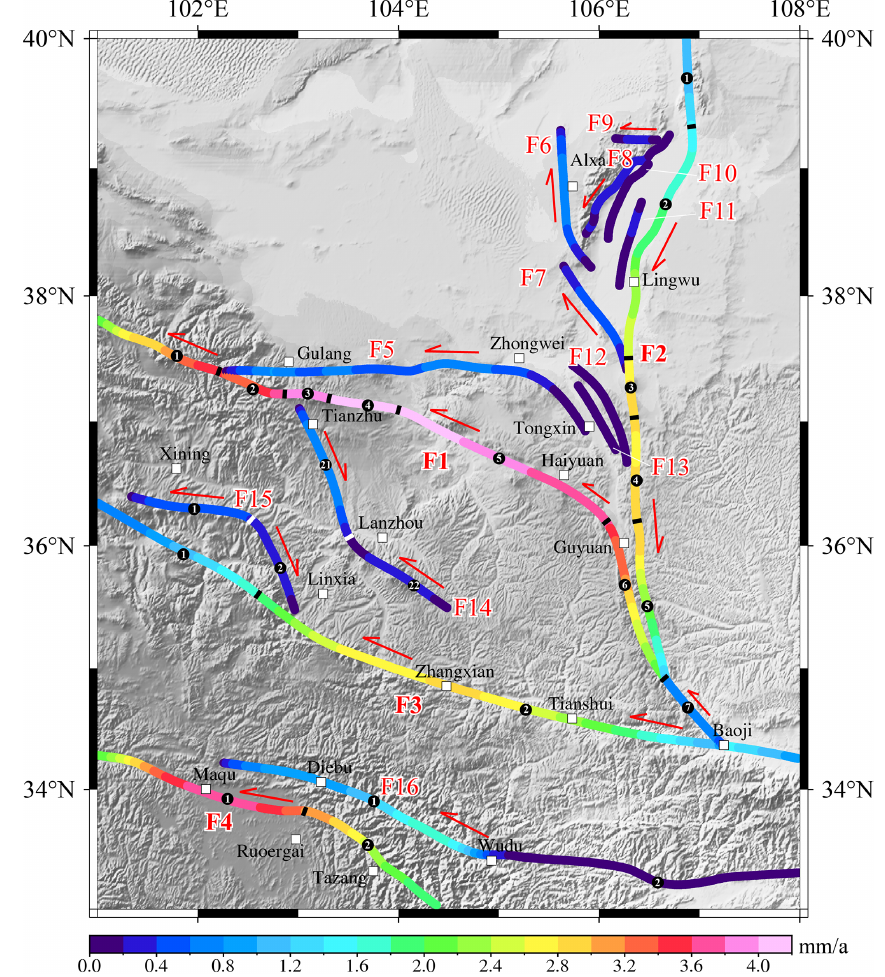
Figure 9. Modeled horizontal fault slip rates and senses. The fault names are defined in Fig.